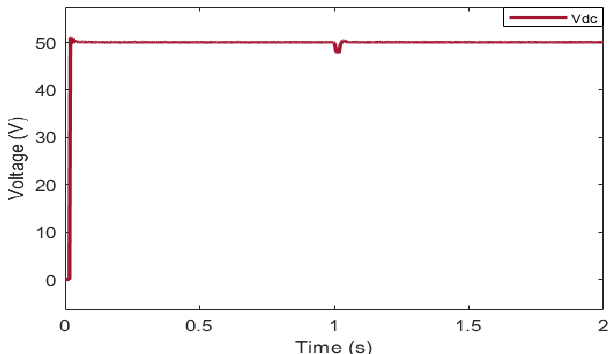
Figure 16. DC bus voltage with load change.